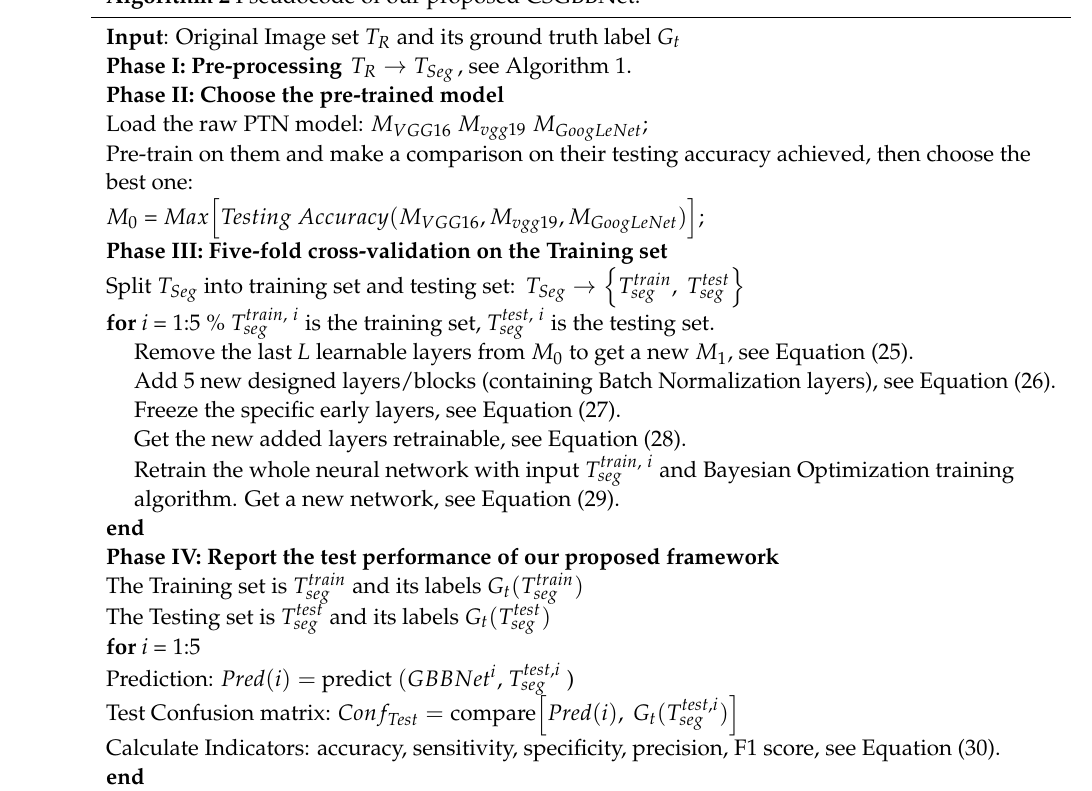
Algorithm 2 Pseudocode of our proposed